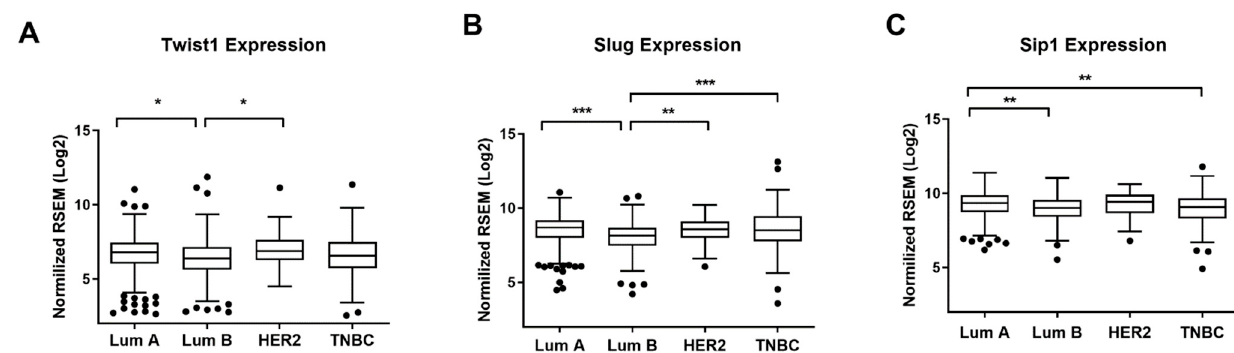
Figure 2. Box-plot graph of TWIST1 ( A ), SLUG/SNAI2 ( B ), and SIP1/ZEB2 expression ( C ) [RNA-Seq by Expectation- Maximization (RSEM), Log2(Val+1)] in Luminal A, Luminal B, HER2+ and triple-negative (TNBC) subtypes. Data are shown as the median ( ± SD), dots represent outliers. Expression values were obtained from TCGA through Linkedomics tools. * p < 0.05; ** p < 0.01; *** p < 0.001.